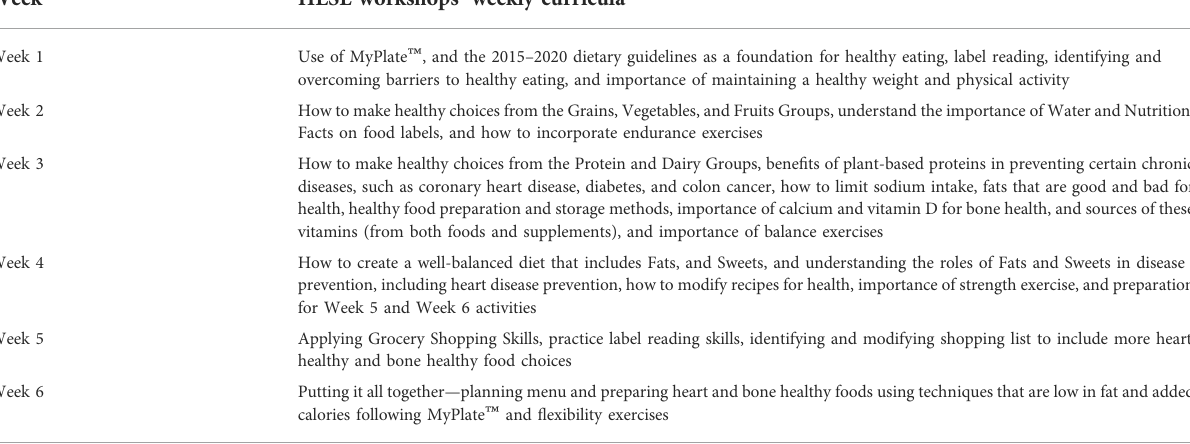
TABLE 1 Summary of healthy eating for successful living workshops ’ weekly